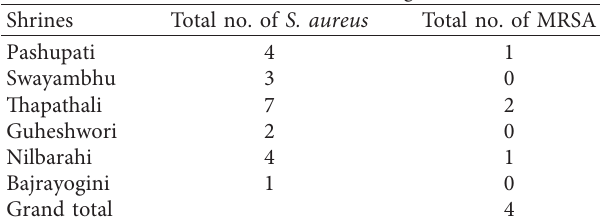
Table 2: Distribution of MRSA among different sites. Shrines Total no. of S. aureus Total no. of MRSA